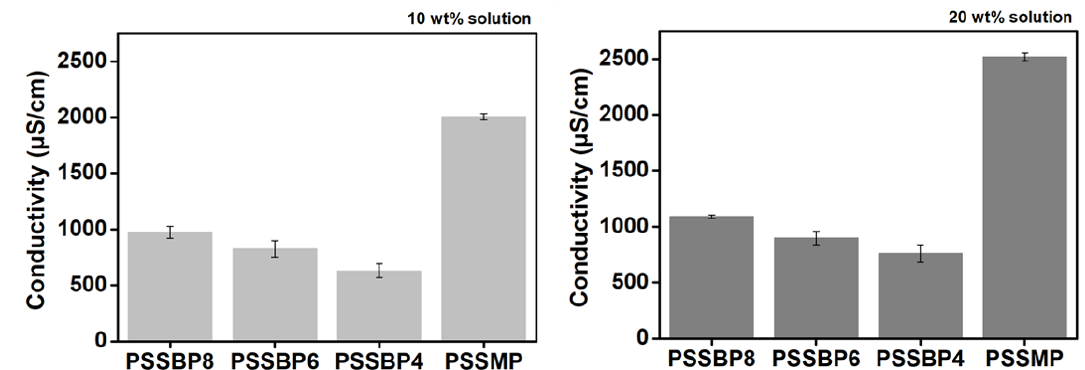
Figure 5. Conductivity of aqueous PSSBP# and PSSMP solutions according to solution concentration.